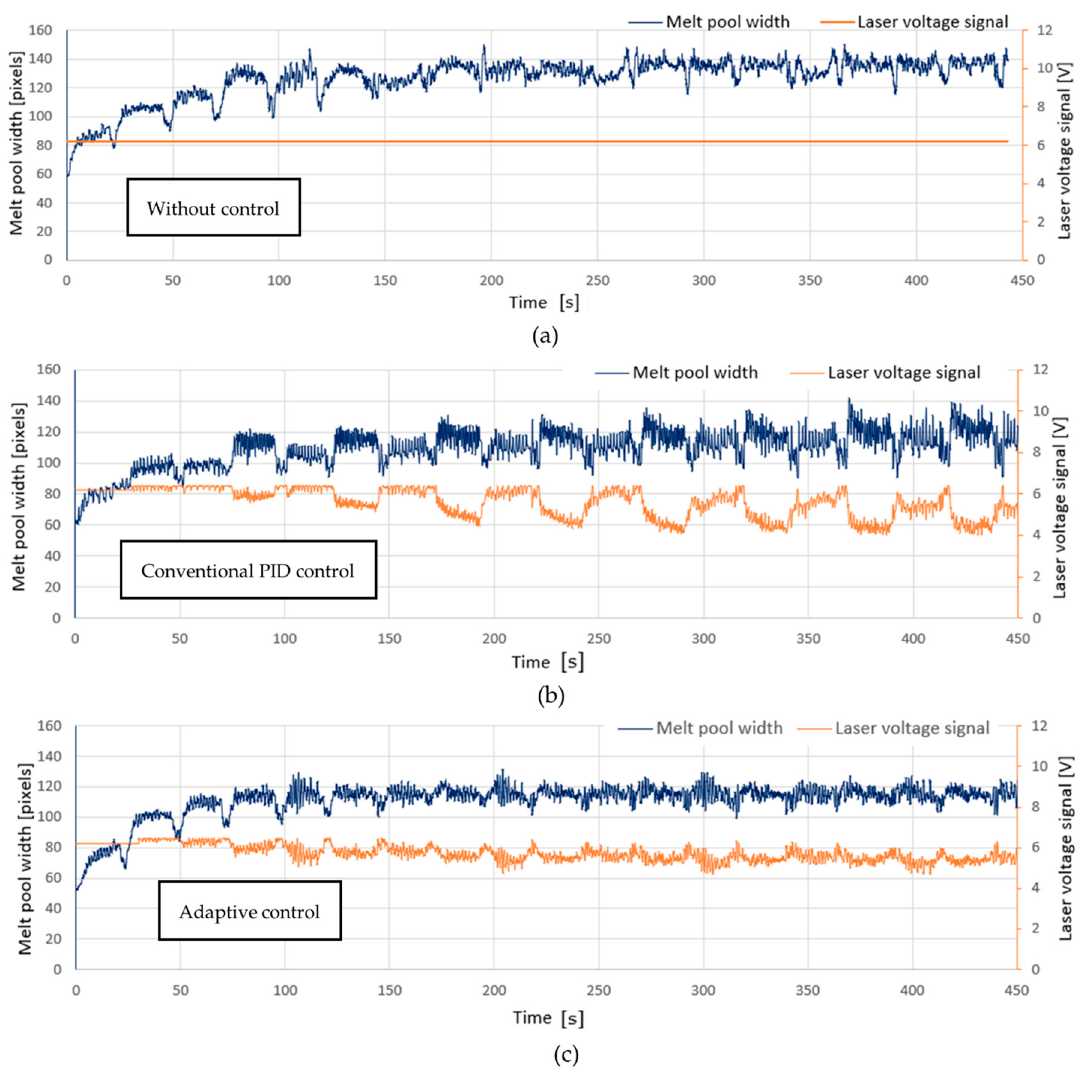
Figure 6. Time plots of the melt pool width (MPW) and laser voltage signals for Experiment 1 (solid semicylinder with the profile tool path, 316 L stainless steel). ( a ) The data without control; ( b ) The data with conventional PID control; ( c ) The data with adaptive control.